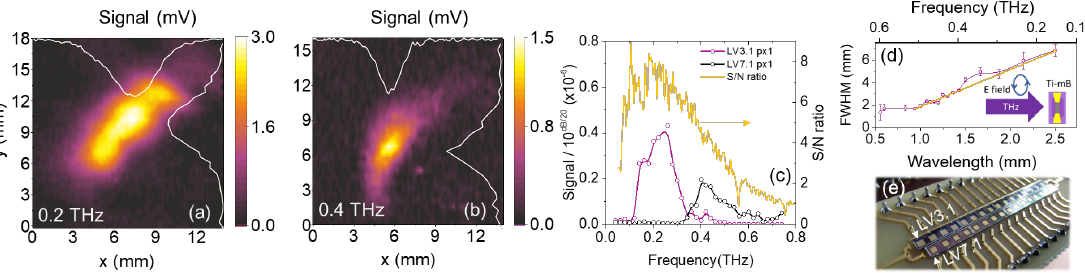
Figure 4. THz beam spatial profiles emitted by low-temperature grown GaAs-based emitter in frequency domain spectrometer at 0.2 THz ( a ) and 0.4 THz ( b ) recorded using a linear array of the bolometers coupled with antennas. White lines indicate intensity cross sections along the relevant axes. Spectral characteristics of the detectors with different resonant dipole antennas and spectra normalized to the spectrometer signal-to-noise ratio (SNR) ( c ); full-width half-maximum (FWHM) dependency on the wavelength with linear approximation depicted by the dark yellow line ( d ), configuration of measurement scheme and polarization are depicted in the inset of ( d ). A photo of dual frequency THz linear array, where the top line of pixels is designed for frequencies around 0.2 THz and the bottom line for frequencies around 0.4 THz. The pixel pitch is 2 mm ( e